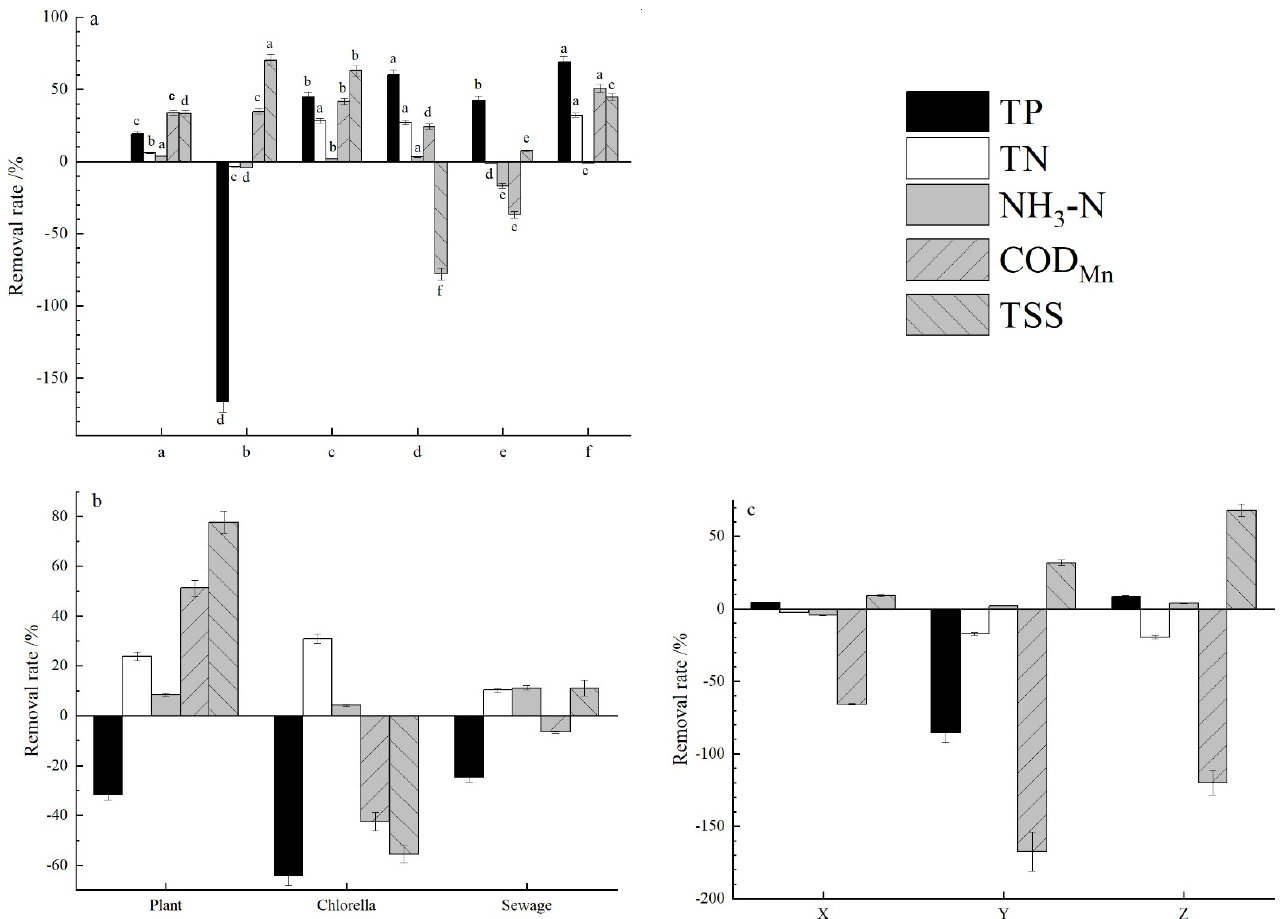
Figure 2. Removal rate for each water quality index in different treatments. ( a ) Six purification materials, ( b ) the single treatment of three purification materials, and ( c ) the three combined materials.